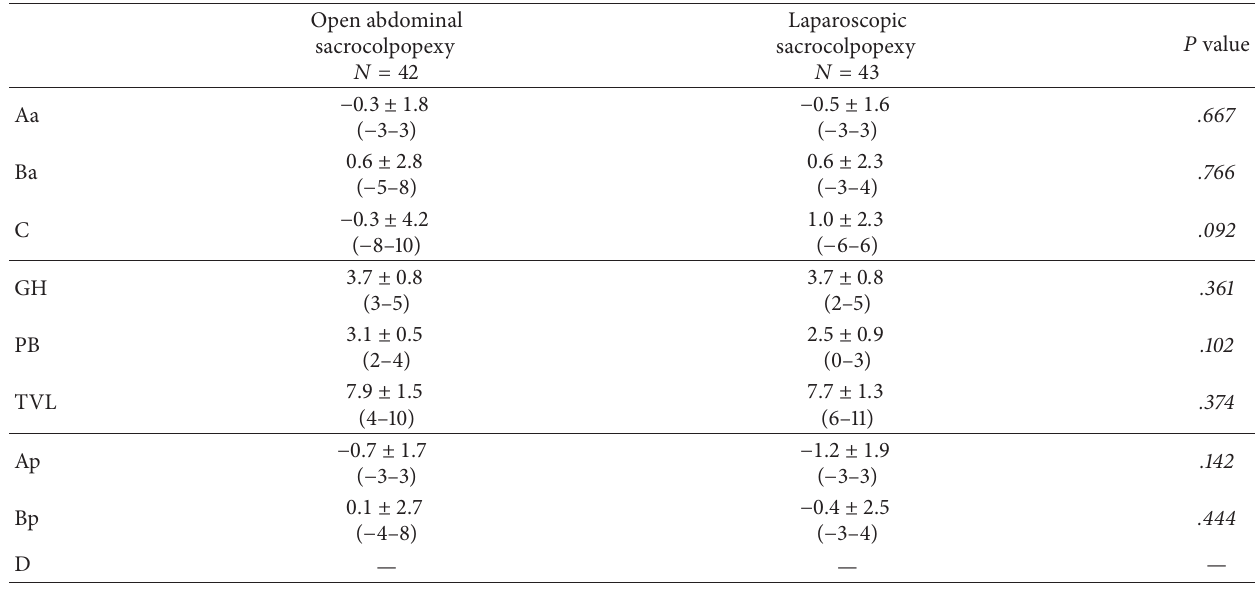
Table 2: Preoperative POP-Q.